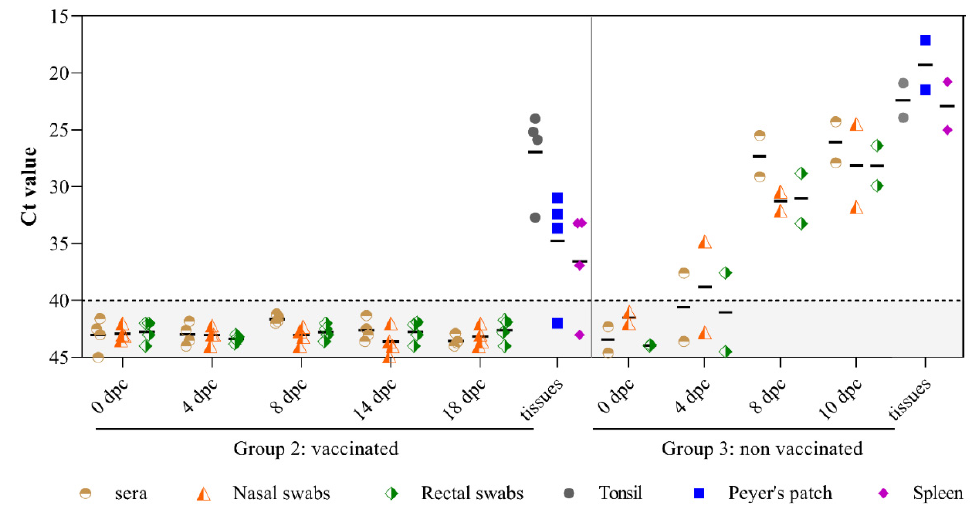
Figure 2. CSFV RNA detection in tissue samples from either vaccinated or non-vaccinated sows after challenge. CSFV RNA in sera, nasal and rectal swabs and tissue samples including tonsil, Peyer’s patch and spleen from the challenged sows was assessed by qRT-PCR. Ct values less than 40 were considered positive.